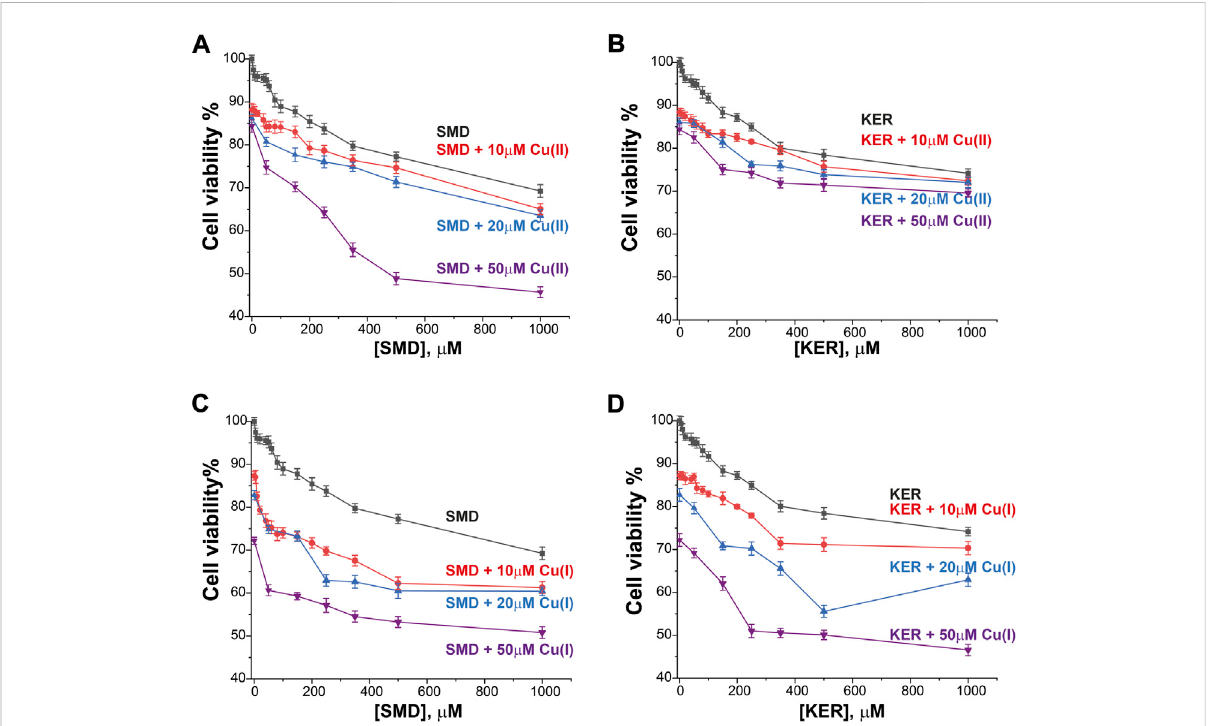
FIGURE 5 MCF7 breastcancer cell viability inthepresence ofSMD peptide atvarying Cu(II) and Cu(I) concentrations in (A) and (C) , respectively, and inthe presence of KER peptide at varying Cu(II) and Cu(I) concentrations in (B) and (D) , respectively. At [peptide] = 0, cell viability in the presence of [Cu(II)/ Cu(I)] is given. Error bars were calculated based on three independent